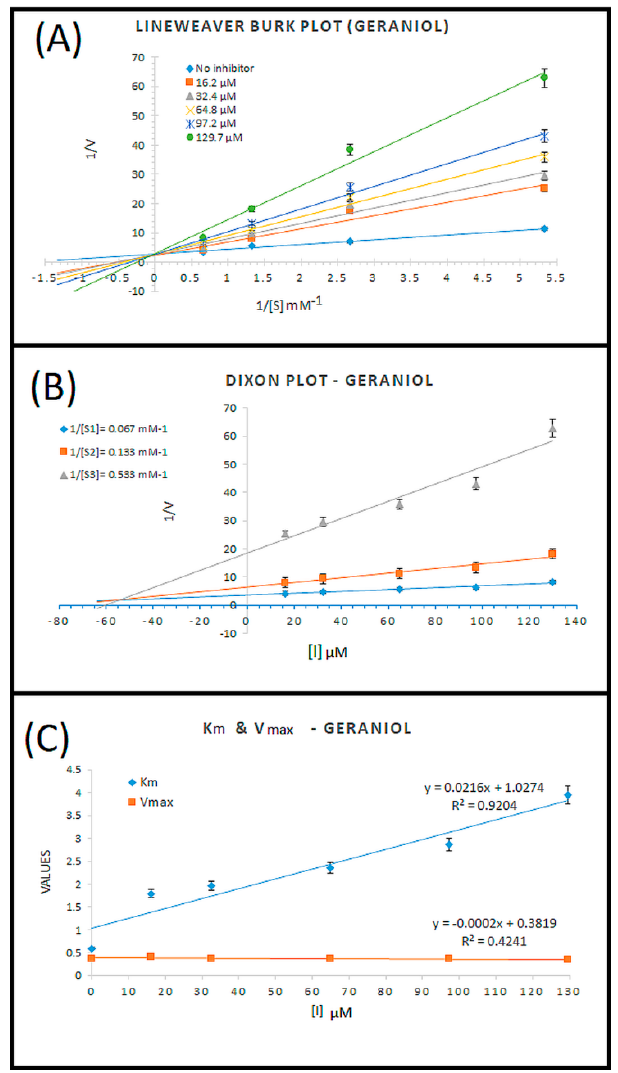
Figure 3. Kinetic analysis results for target molecule geraniol. ( A ) Lineweaver-Burk plots for the inhibition of AChE in the presence of compound geraniol at varying concentrations (0, 16.2, 32.4, 64.8, 97.2, and 129.7 uM, respectively) and substrate at varying concentrations (0.187, 0.375, 0.75, and 1.5 mM, respectively); ( B ) Dixon plot; and ( C ) variations in Km and Vmax at different concentrations of geraniol.